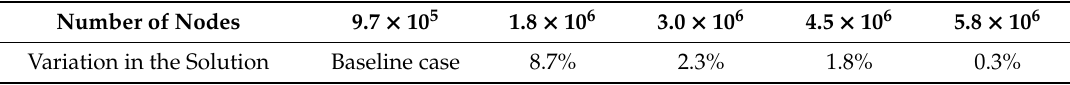
Figure 2. Detail of the fluid domain mesh. Table 3. Mesh independence study